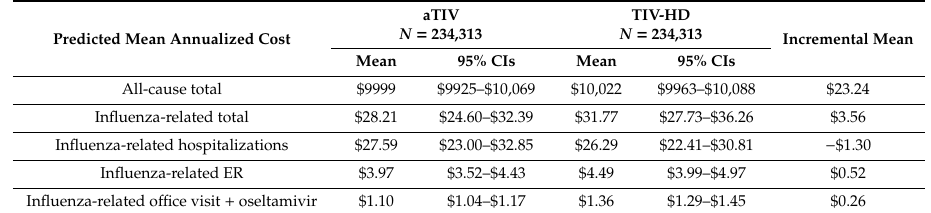
Table 3. Economic outcomes—post propensity score matching (PSM) and generalized estimating equation model (GEE)